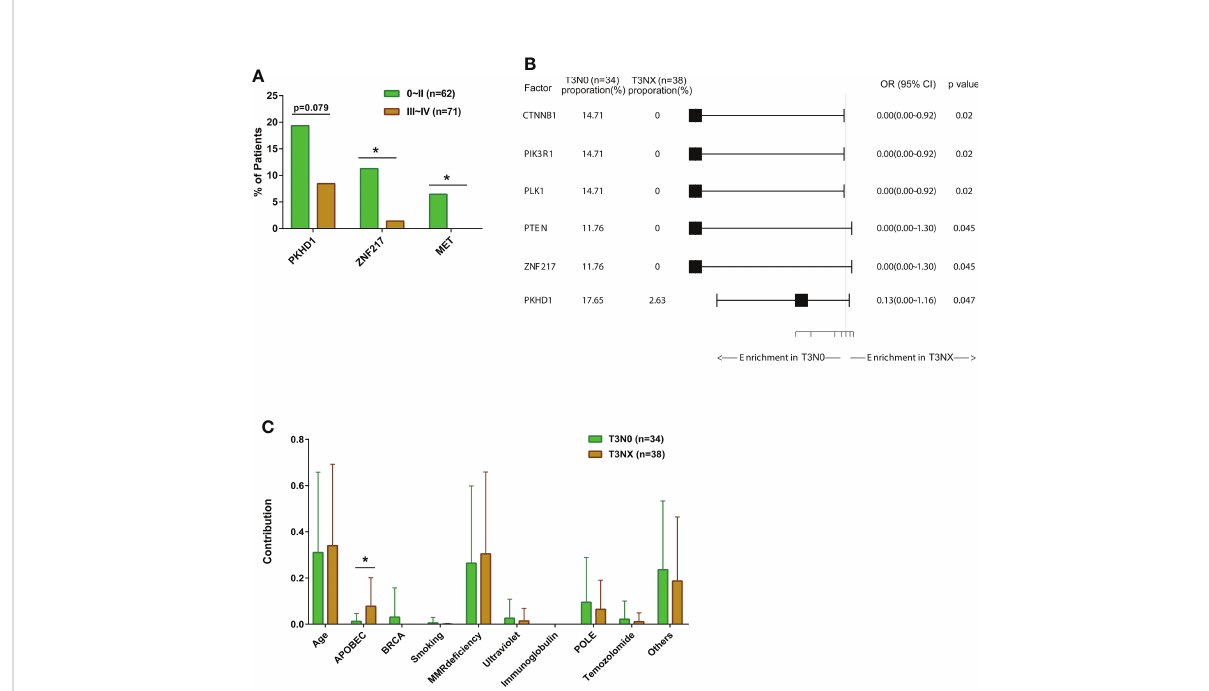
FIGURE 3 The comparisons of somatic mutation characteristics and signatures among colorectal cancer patients with different stages. (A) The bar plots comparing gene alteration rates in early- (Stage 0~II, N=62) and late-stage patients (Stage III~IV, N=71). (B) Forest plot of somatic mutation rates of stage III colorectal cancer patients with metastatic disease (T3N0, N=34) compared to patients without metastatic disease (T3NX, N=38). (C) The bar plots comparing somatic mutation signatures between patients with metastatic disease (T3N0, N=34) and patients without metastatic disease (T3NX, N=38). *p < 0.05.